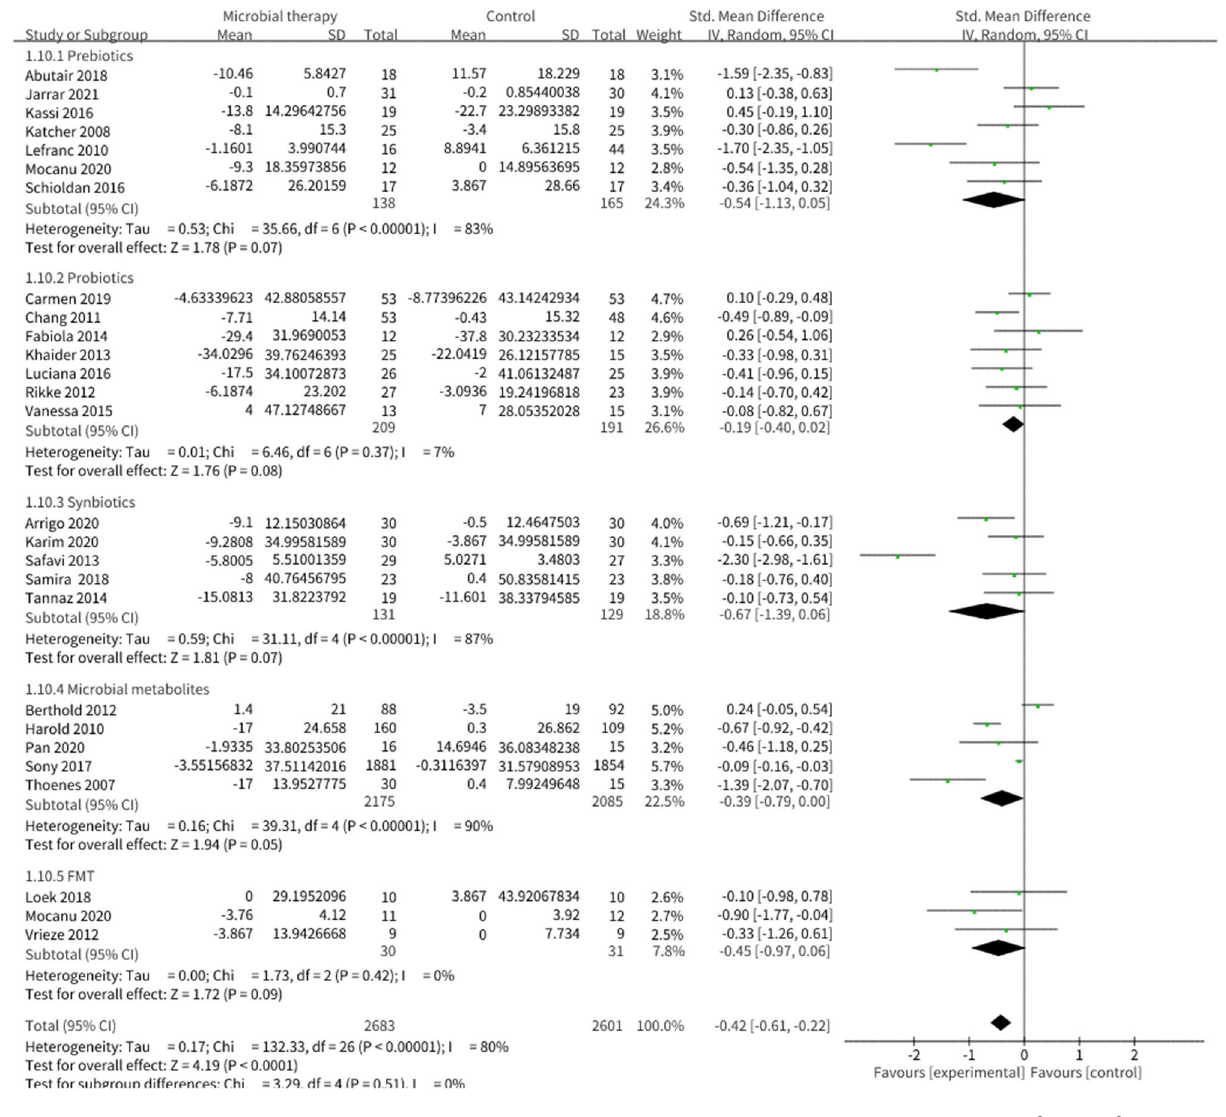
FIGURE 5 | Comparison of SMD of low-density lipoprotein cholesterol (LDL-C) control between intervention groups and control groups Tau 2 = 0.17, I 2 = 80%, 95% CI − 0.61 to − 0.22, Z = 4.19, p < 0.0001. Significant differences were shown in